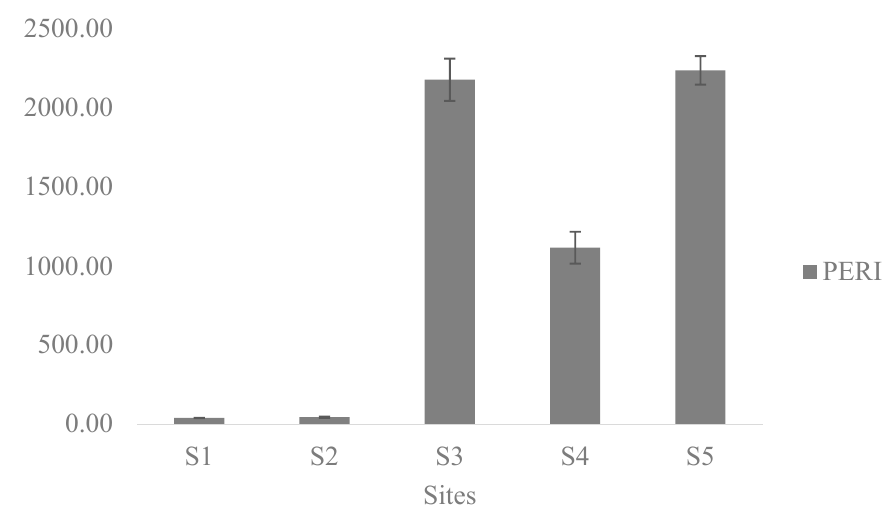
Figure 2. Potential ecological risk index in sediments across the sites. PERI = Potential Ecological Risk Index.